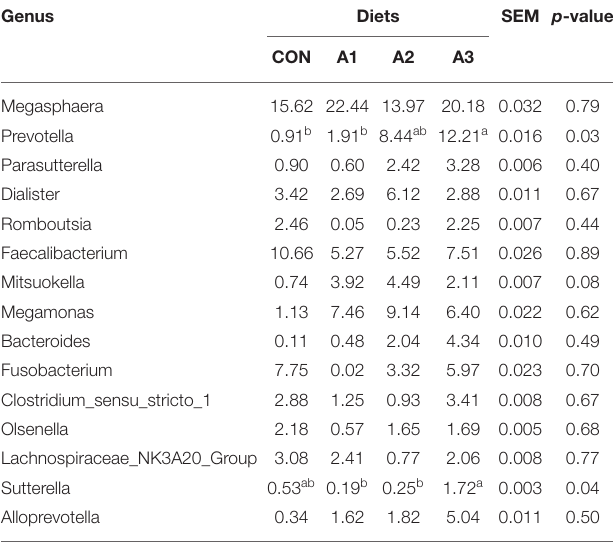
TABLE 6 | Effects of Anemoside B4 on the comparison of dominant genus of suckling calves at 28 days of age (%). Genus